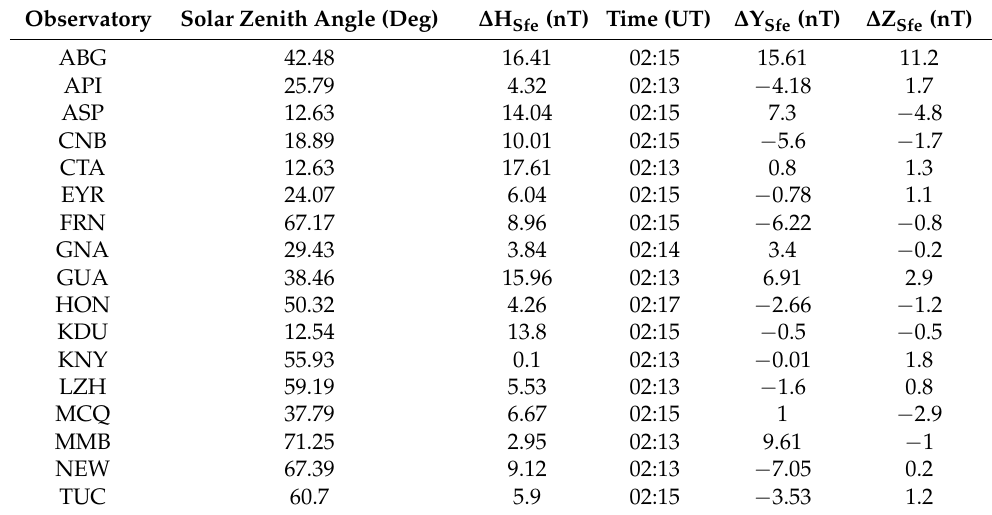
Table 6. The magnetic response to the solar flare X1.5 of 3 July 2002.